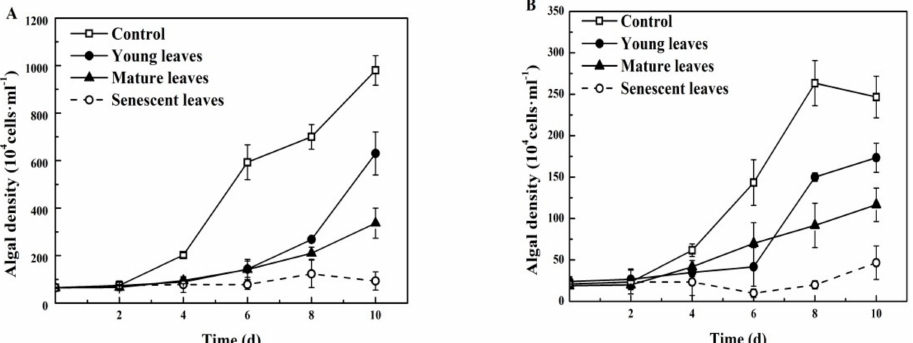
Figure 2. Harmful algae density of P. globosa following treatment with mangrove leaf aqueous extracts of different leaf age: ( A ) B. gymnorrhiza and ( B ) K. candel . The data are expressed as the mean ± standard error of the mean; n = 3 in each